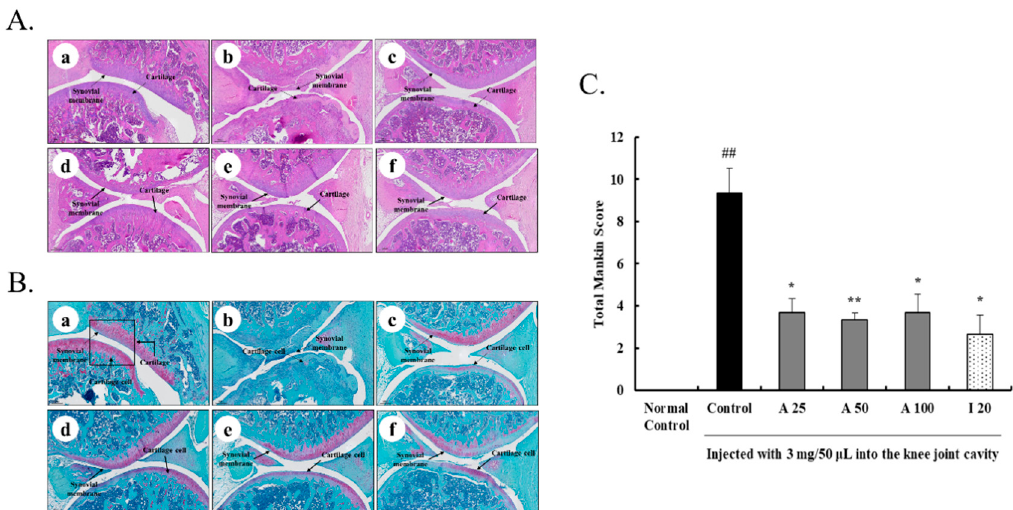
Figure8. E ff ectsofAyuFlex ® onjointpathologyinMIA-incurredOAinrats. ( A )Kneejointswerestained Figure 8. Effects of AyuFlex ® on joint pathology in MIA-incurred OA in rats. ( A ) Knee joints were with H&E and ( B ) Safranin-O, ( C ) and graded on a scale 0-13 scale using the Mankin scoring system. stained with H&E and ( B ) Safranin-O, ( C ) and graded on a scale 0 ‒ 13 scale using the Mankin scoring (a) Normal Control group, (b) MIA Control group, (c) MIA + AyuFlex ® 25 mg / kg, (d) MIA + AyuFlex ® system. (a) Normal Control group, (b) MIA Control group, (c) MIA + AyuFlex ® 25 mg/kg, (d) MIA + 50 mg / kg, (e) MIA + AyuFlex ® 100 mg / kg, and (f) MIA + Ibuprofen 20 mg / kg. The results are AyuFlex ® 50 mg/kg, (e) MIA + AyuFlex ® 100 mg/kg, and (f) MIA + Ibuprofen 20 mg/kg. The results